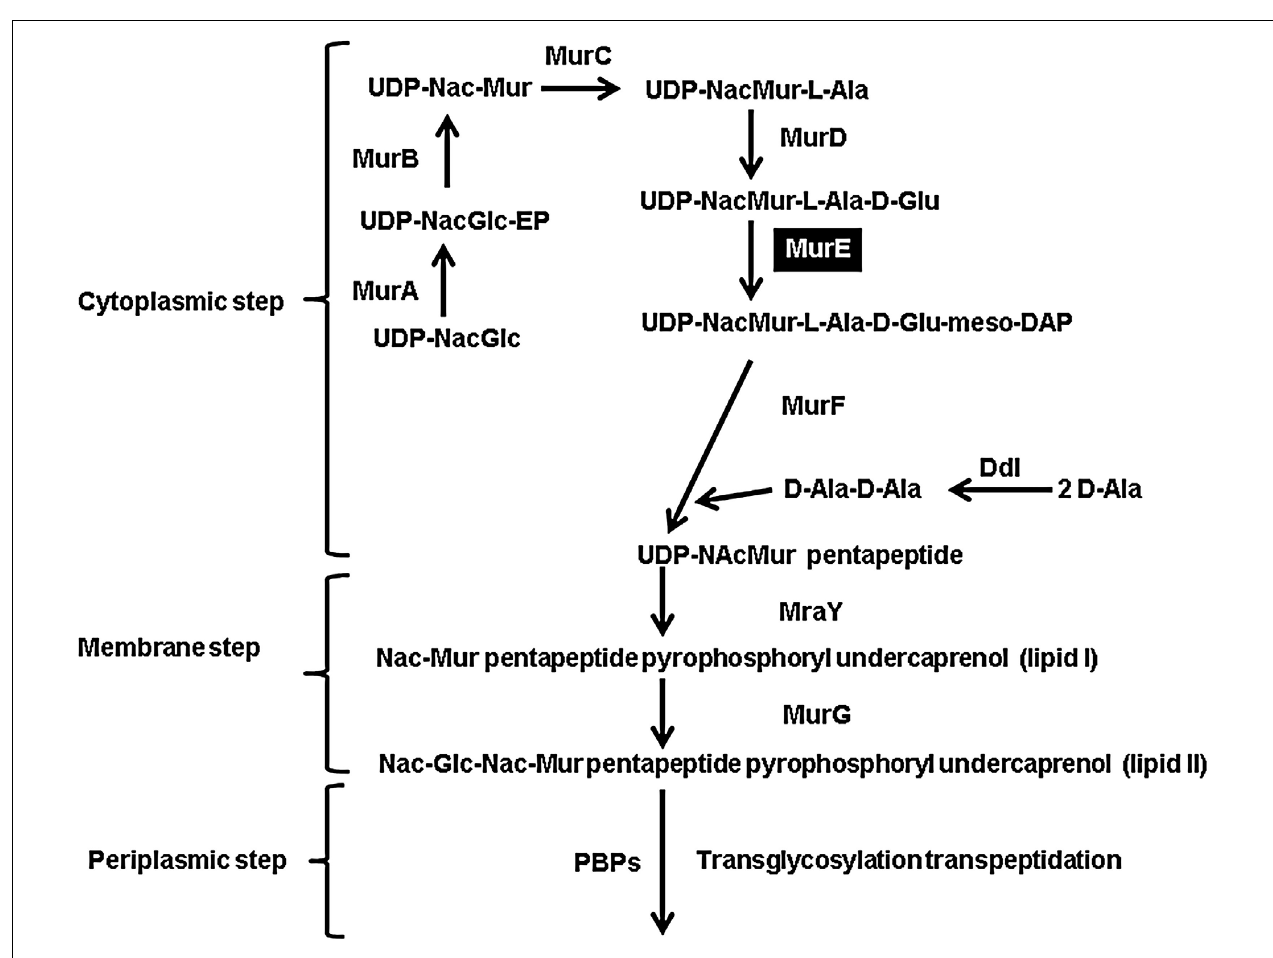
muramoylalanine-D-glutamate ligase), MurE (UDP- N -acetylmuramoyl- L -alanyl-D-glutamate 2,6- meso -diaminopimelate ligase), MurF (UDP- N -acetylmuramoyl-tripeptide-D-alanyl-d-alanine ligase), Ddl (D-alanine-D-alanine ligase B), MraY (phospho- N -acetylmuramoyl- pentapeptide-transferase), MurG (pyrophosphoryl-undecaprenol- N -acetylglucosamine transferase), and PBPs (penicillin binding